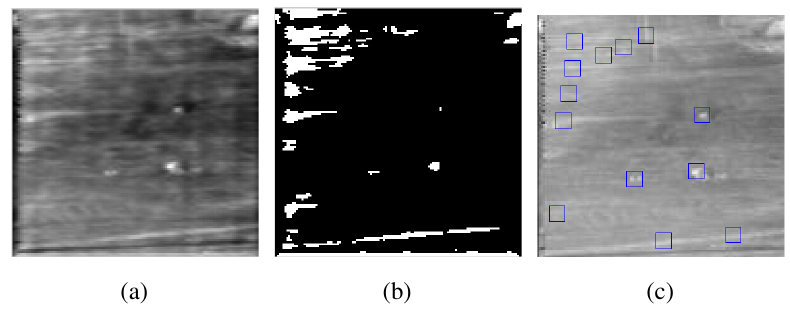
Figure 6. Figures of hypercomplex Fourier transform (HFT). ( a ) saliency map of HFT method; ( b ) result of threshold operation; ( c ) final result marked by blue